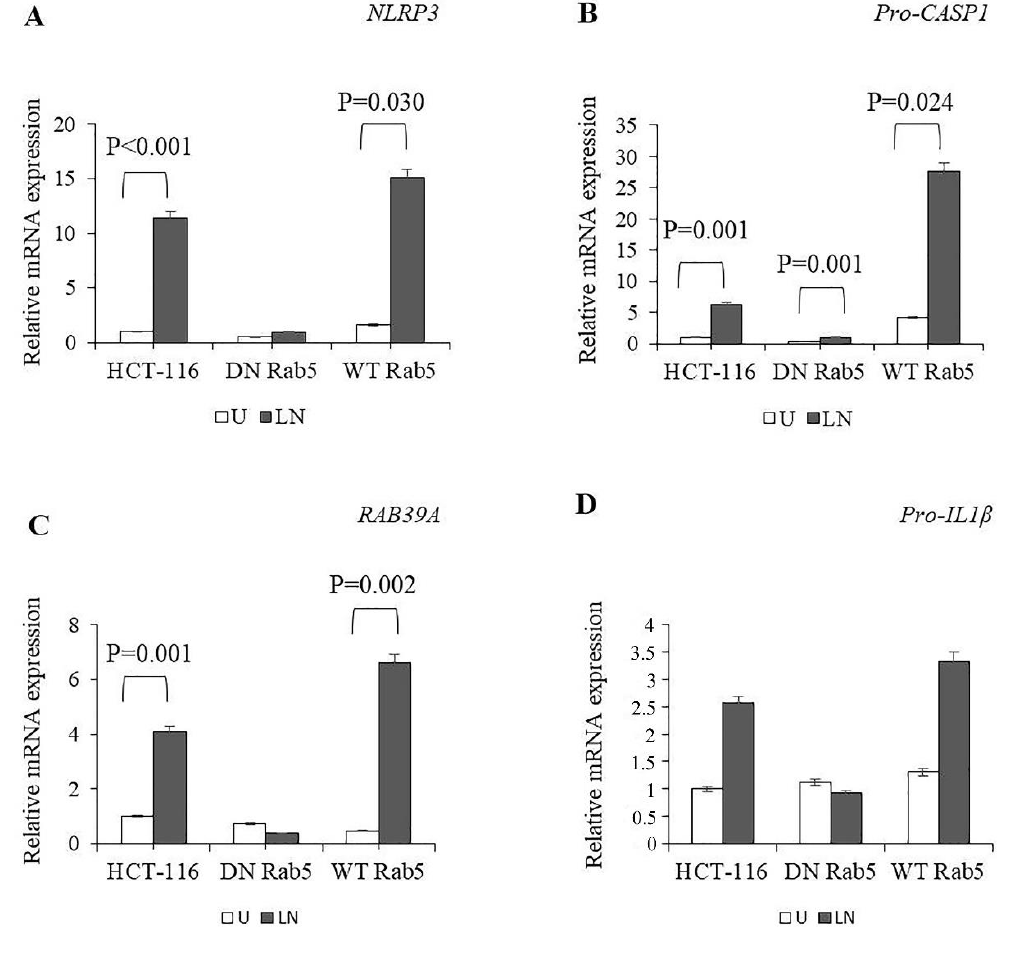
Figure 2. The effects of Rab5 on the NALP3 inflammasome. To assess NALP3 activation, HCT116 cells transfected with pDsRed-Rab5 WT and pDsRed-Rab5 DN were primed with LPS (1 µg/ml) for 3 hours and then treated with nigericin (20 µM) for 24 hours. ( A – D ) The effects of DN Rab5 and WT Rab5 on the expression of NLRP3 , RAB39A , Pro-CASP1 and Pro-IL1β in the untreated and LPS/nigericin- treated HCT116 cells. ( E ) The DN Rab5 and WT Rab5 effect on IL1β secretion in the untreated and LPS/nigericin-treated HCT116 cells. U: untreated; LN: LPS/nigericin treated ( n = 3 for each experiment; p -values were calculated using independent sample T test).